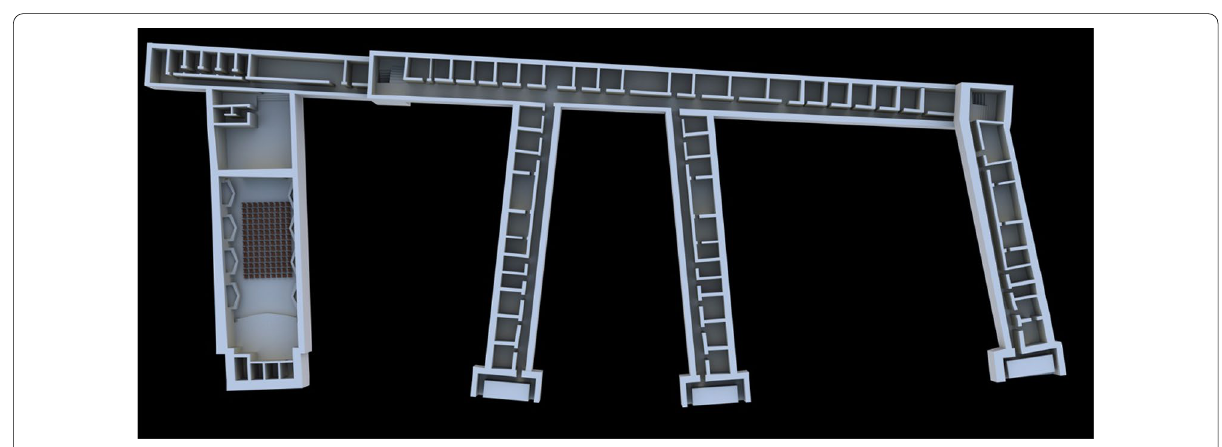
Fig. 6 Plan of the new museum Bunkart 1, curated by Carlo